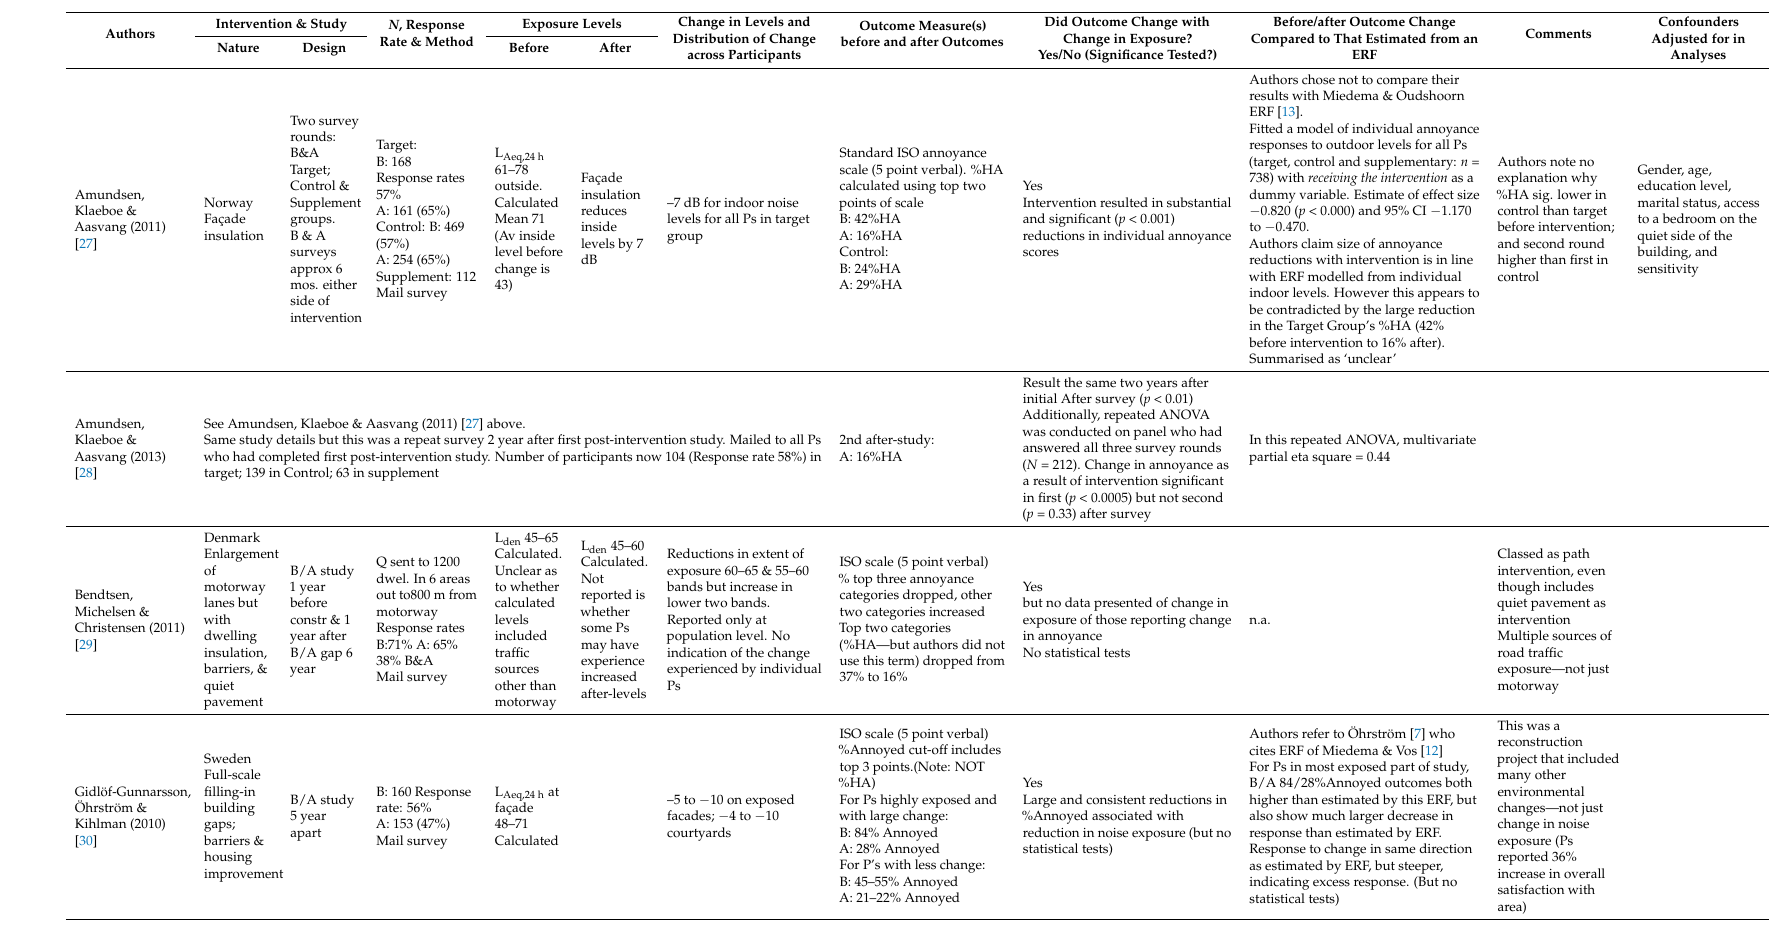
Table 4. Path Interventions (Type